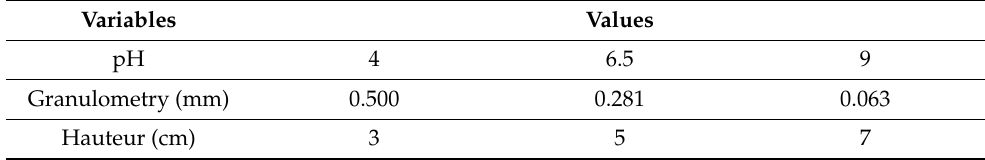
Table 7. Box-Behnken design